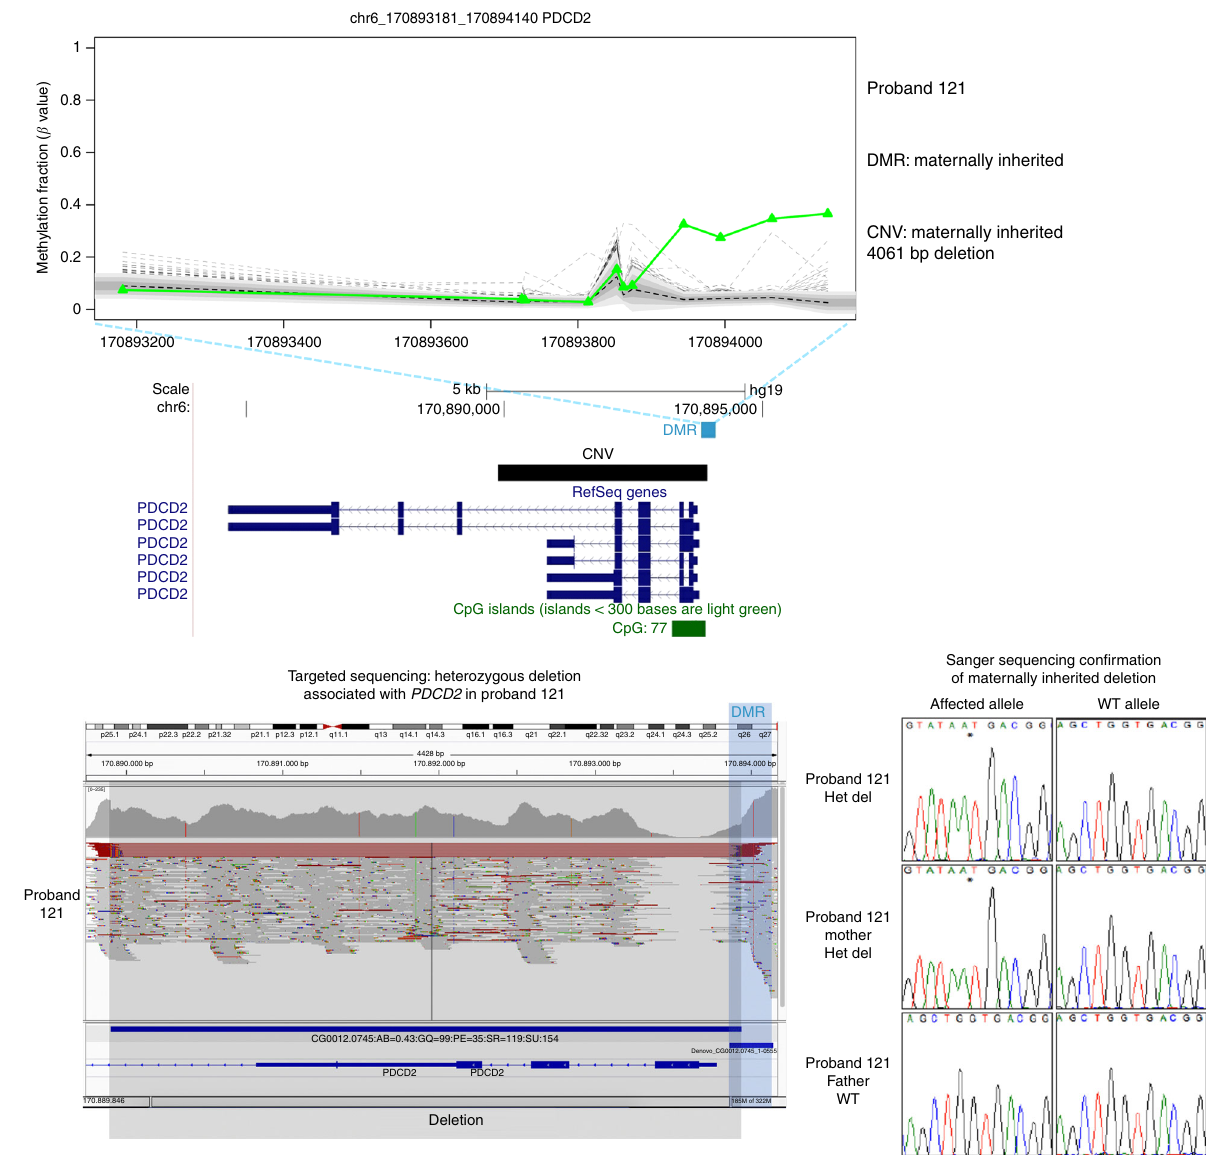
Fig. 3 Detection of rare CNVs by targeted sequencing of epivariations and their fl anks. Proband 121 carries a maternally inherited DMR at the PDCD2 locus. We identi fi ed a maternally inherited heterozygous 4061 bp deletion fl anking the DMR. Two other similar examples are shown in Supplementary Fig.